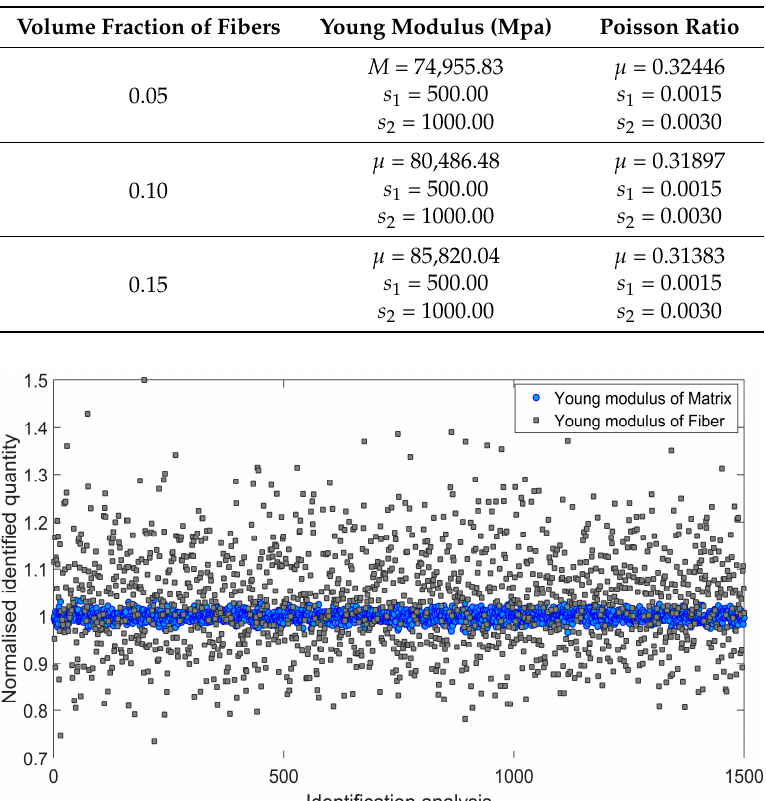
Table 4. Statistical properties of composites reinforced with three different volume fractions of reinforcement which serves as an input data to Monte Carlo simulations.